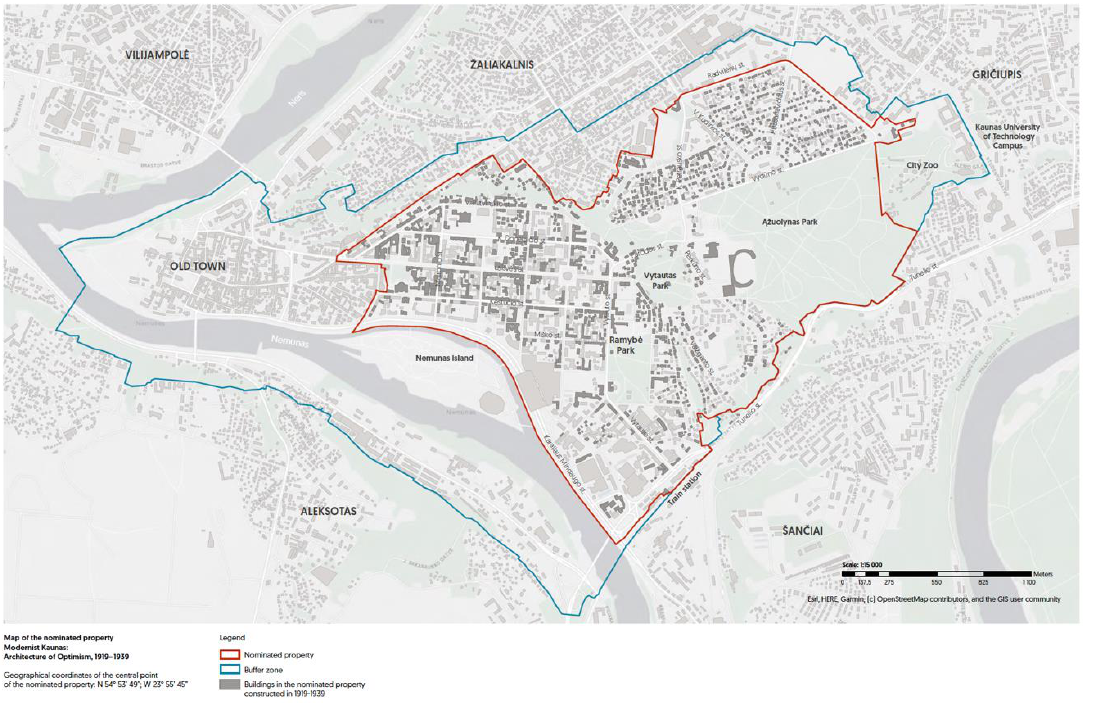
Figure 2. Position of the nominated property (red) and buffer zone (blue). Naujamiestis (on the left) spans a territory of 226 hectares and Žaliakalnis (on the right) has a total area of 243 hectares. The nominated property covers a total area of 451.6 ha. Drawing by Živilė Šimkutė and Sigita Bugenienė, 2021.